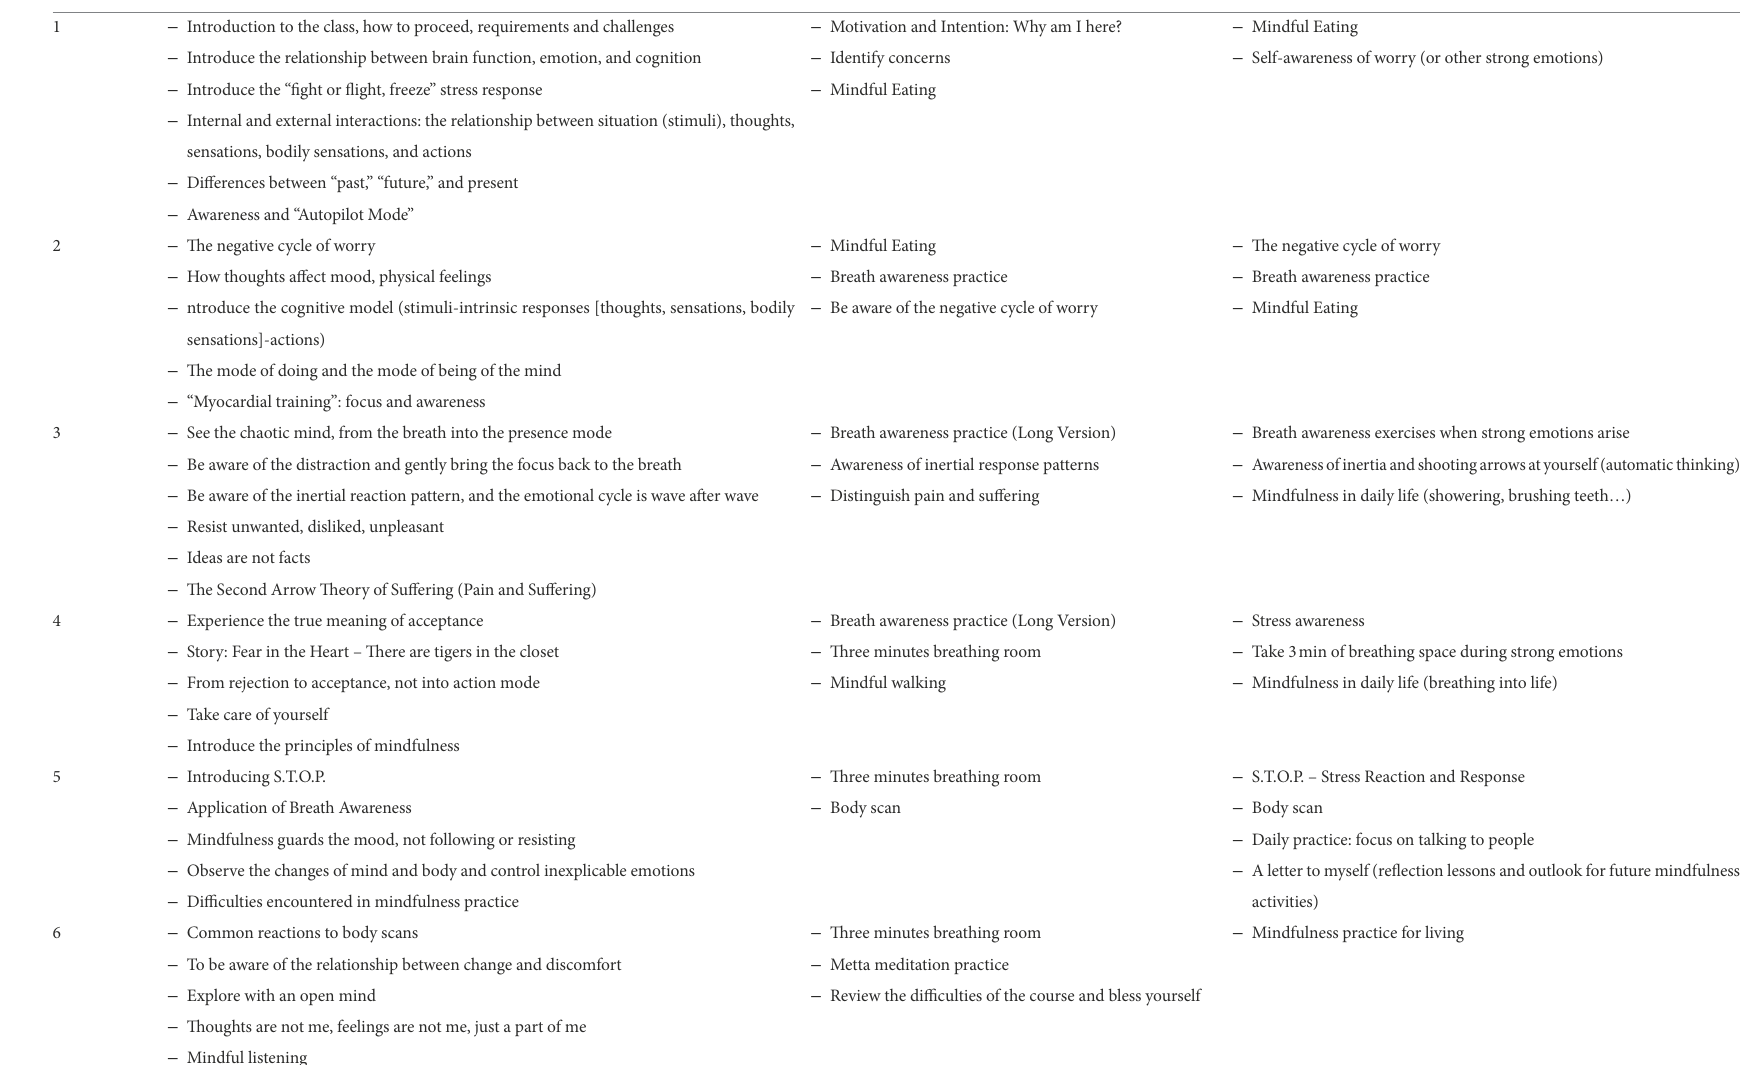
TABLE 2 The content of